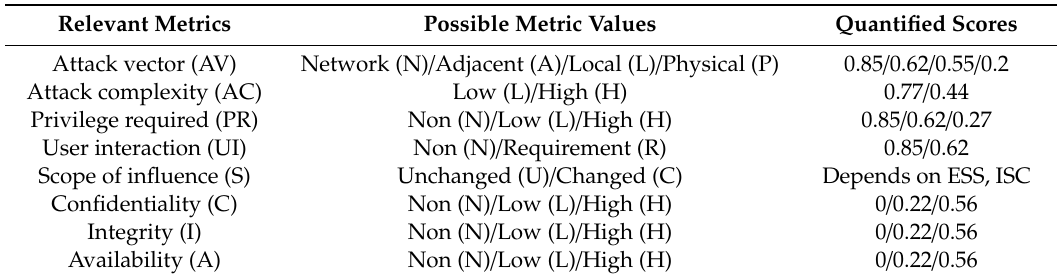
Table 1. Base score calculation-related metrics.